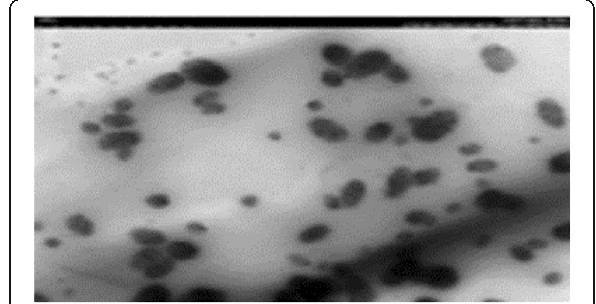
Fig. 2 Scan electron microscopic analysis of AgNPs that are biofabricated by Pseudomonas